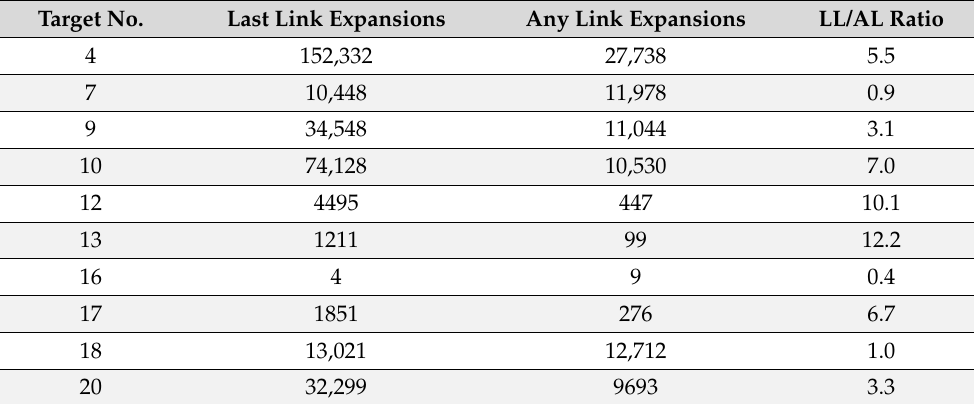
Table 3. Expansion within the A* search for last link and any link. The target list corresponds to the numbering in Figure